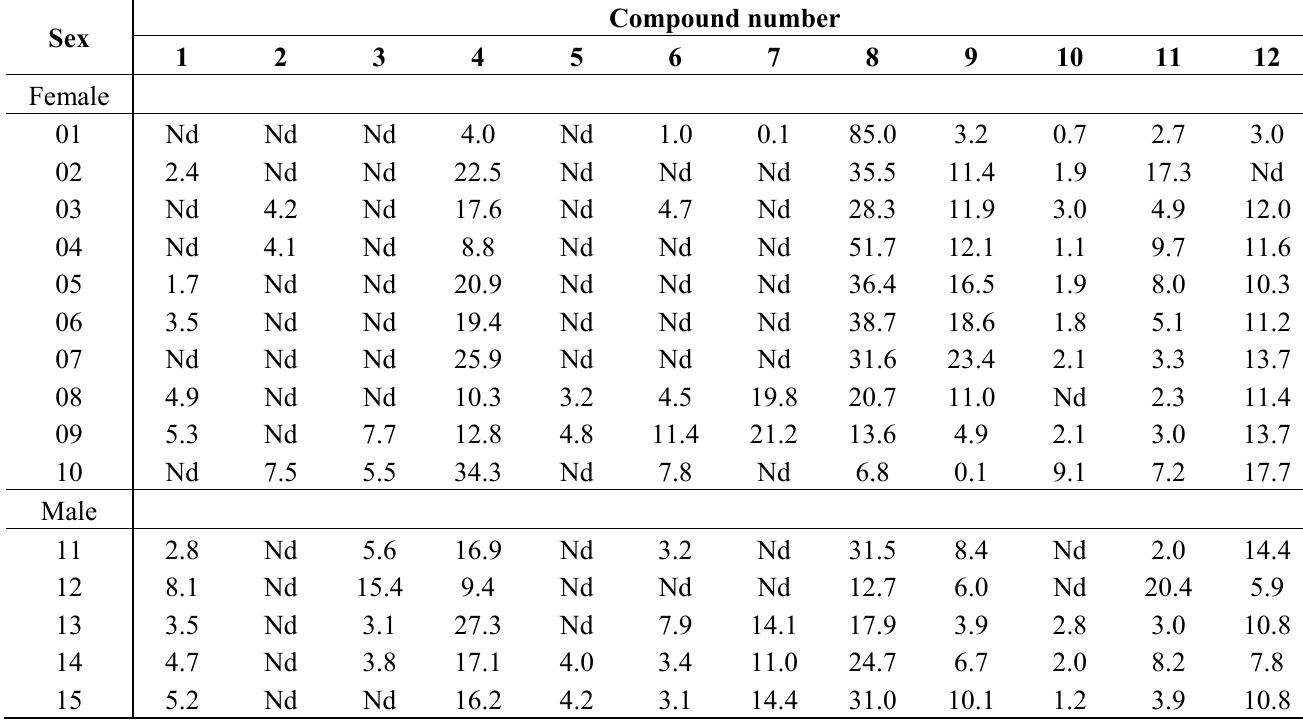
Table 4. Relative percent composition of the Austrocedrus chilensis resin diterpenes measured by GC-MS (as methyl esters). Samples collected in November 2010. Samples 1–10 are from female trees, 11–15 from male trees. Nd: not